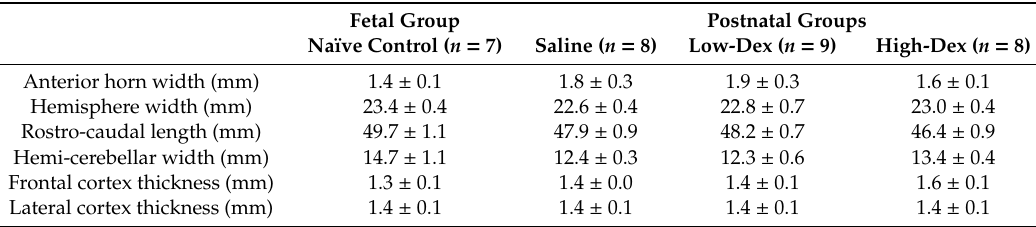
Table 3. Anatomical measures of preterm lamb brains.